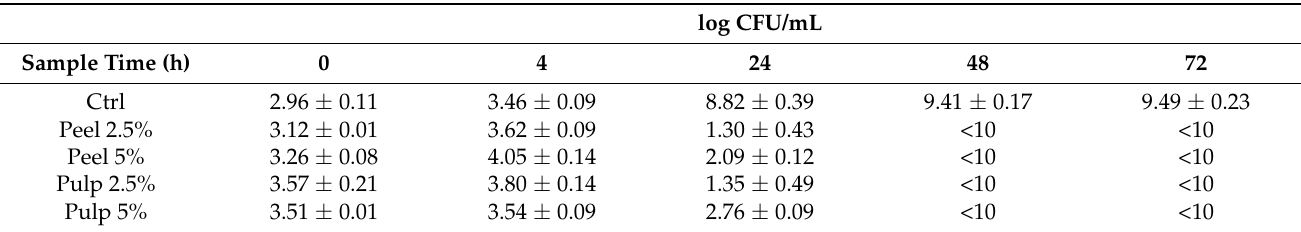
Table 2. Evolution of the Pseudomonas spp. viable cell concentration after inoculation of control and prickly pear peel (2.5% and 5%) and pulp (2.5% and 5%) powder. Data indicate means ±